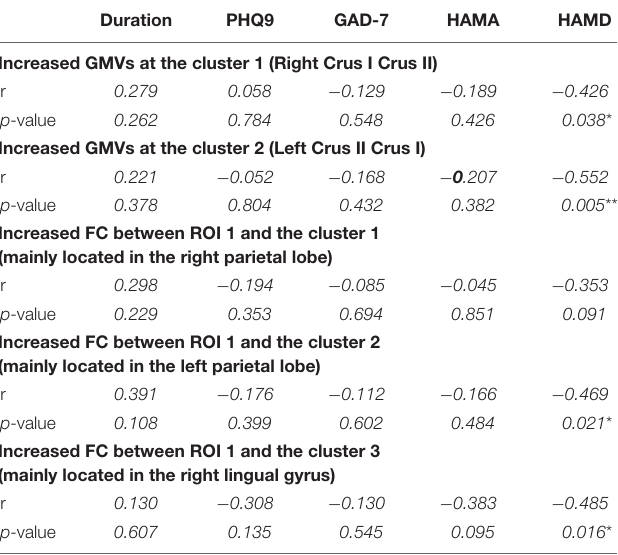
TABLE 4 | Correlations between the clinical characteristics and altered GMV (and FC) in the SSD patients. Duration PHQ9 GAD-7 HAMA